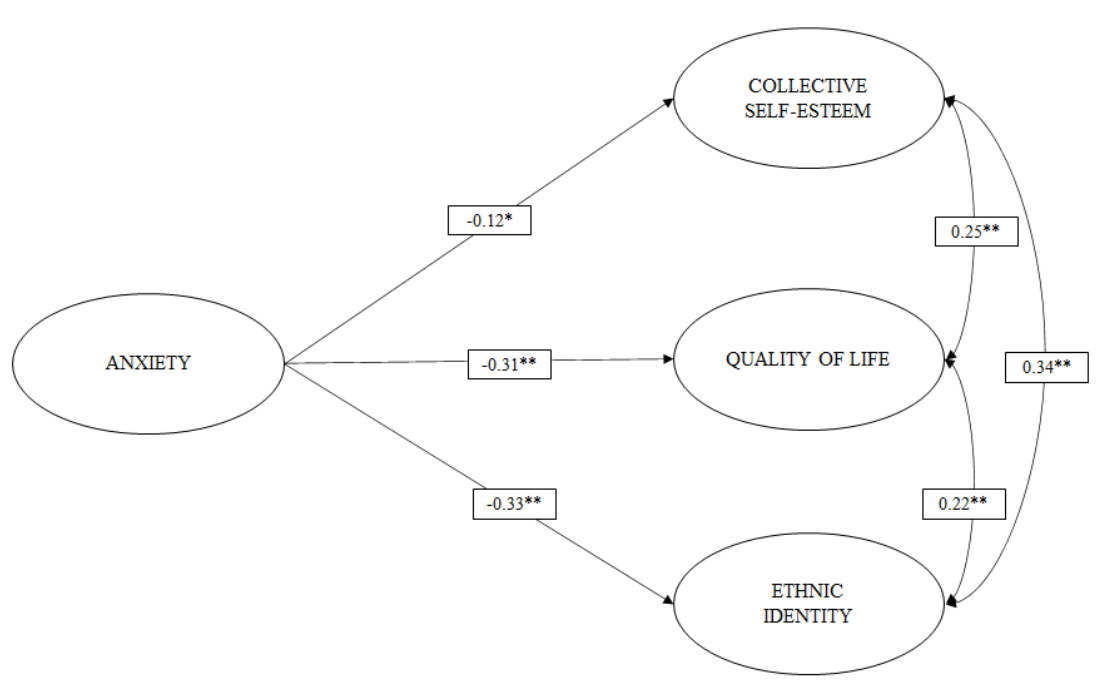
Figure 1. M6 Structural model where anxiety has an effect on collective self-esteem, ethnic identity, and QoL. The analysis controlled for the effects of years of stay, sex, and age. * p < 0.05; ** p < 0.001. M7 (Figure 2) shows that depression has a small negative effect on collective self-esteem (b = − 0.171) and ethnic identity (b = − 0.191) and a moderate negative effect on QoL (b = − 0.287).